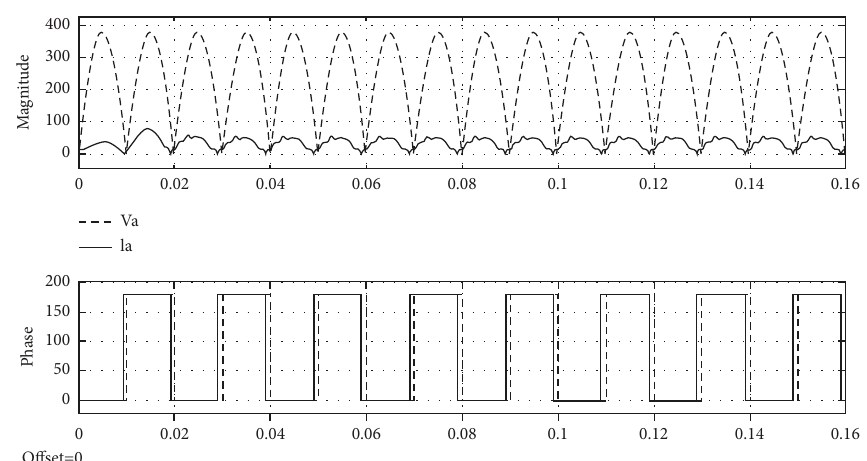
Figure 8: Input voltage and current waveform in amplitude-phase